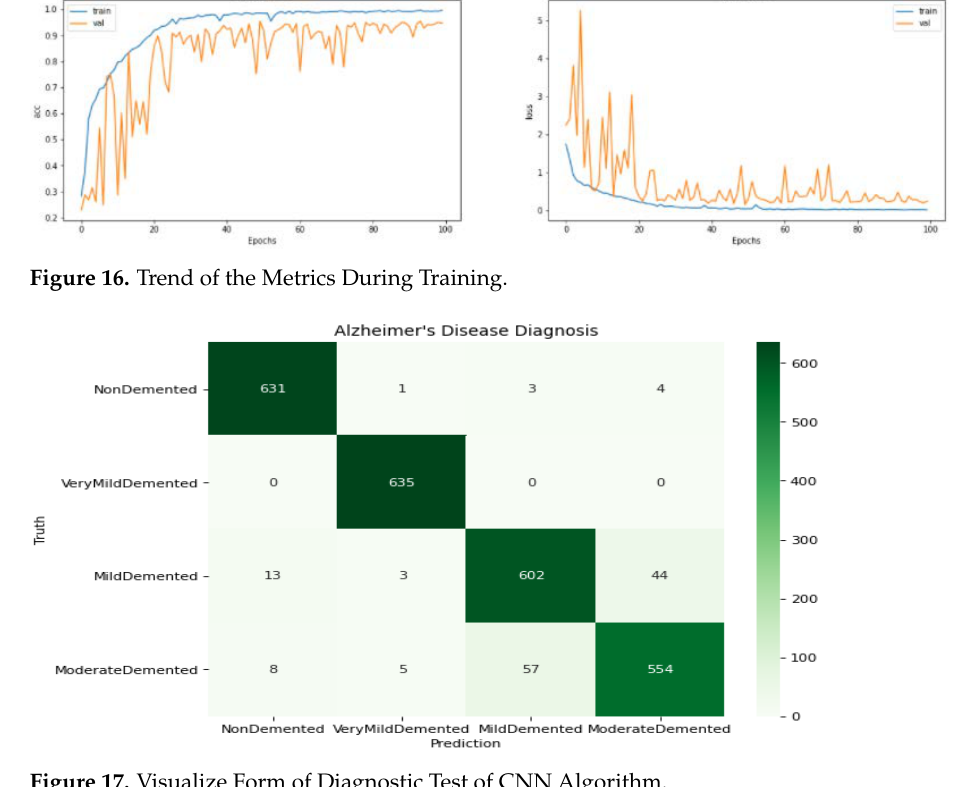
Figure 17. Visualize Form of Diagnostic Test of CNN Algorithm .